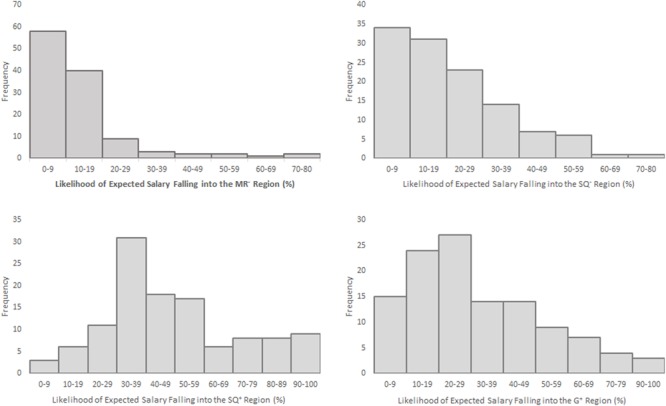
Histograms of likelihood estimates of expected salary falling into the MR-, SQ-, SQ+, and G+ zones in Study 1. MR- zone: expected salary after a pay cut was below MR; SQ- zone: expected salary after a pay cut was above MR and below SQ; SQ+ zone: expected pay raise was above SQ and below G; G+ zone: expected pay raise was above G.